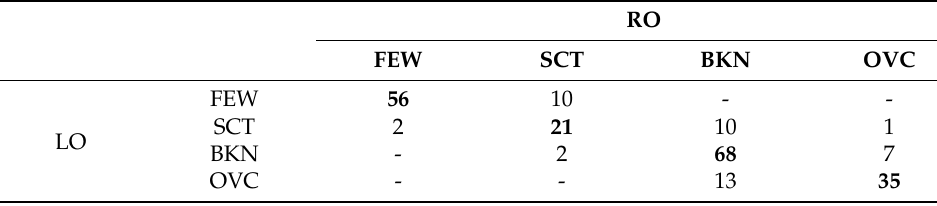
Table 3. The same as in Table 2, but for the remote observers (RO) and the local observers (LO).